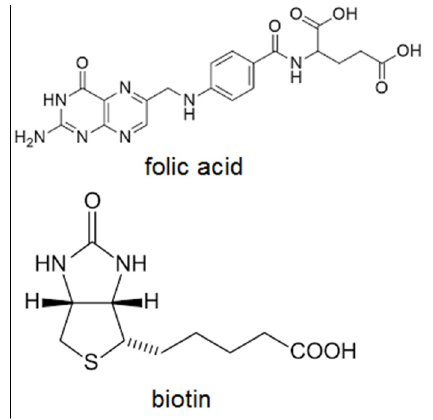
Figure 1. Chemical structure of folic acid and biotin. However, since the receptors (surface markers) of tumour cells change dynamically with tumour progression [29], the multiple ligand-coated nanostructures have been found to improve the identification of the tumour cells